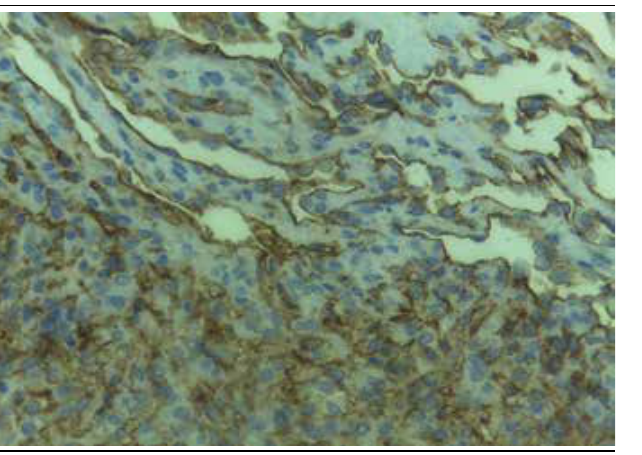
figuRE 6 − Immunohistochemistry showing lesion positive for CD31 (400×) CD31: cluster of differentiation 31.